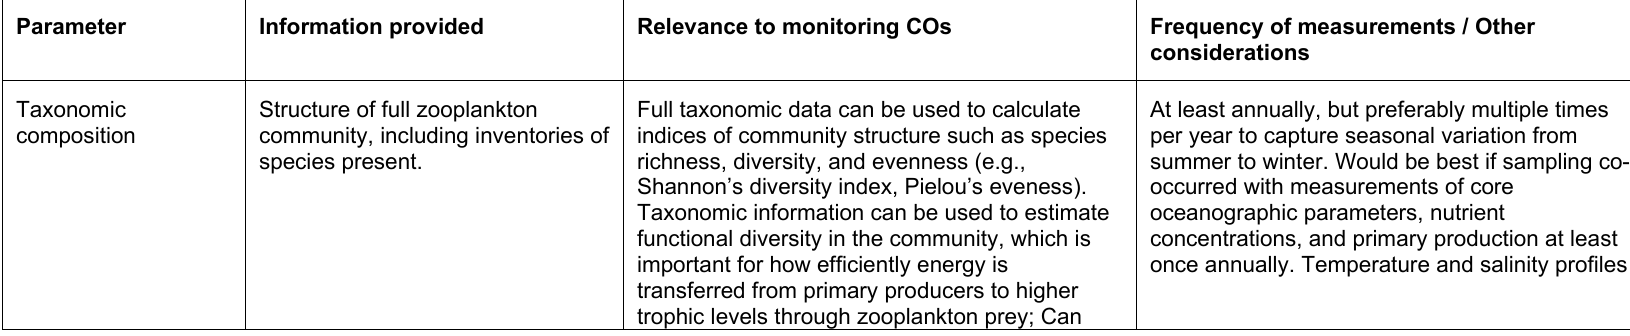
Table C6.3. Key measurement parameters for monitoring zooplankton community composition, structure, and function (Section 6.3).